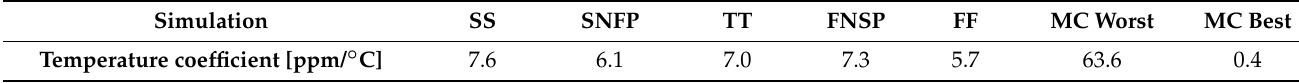
Table 4. Simulation-based temperature coefficients of PGA.